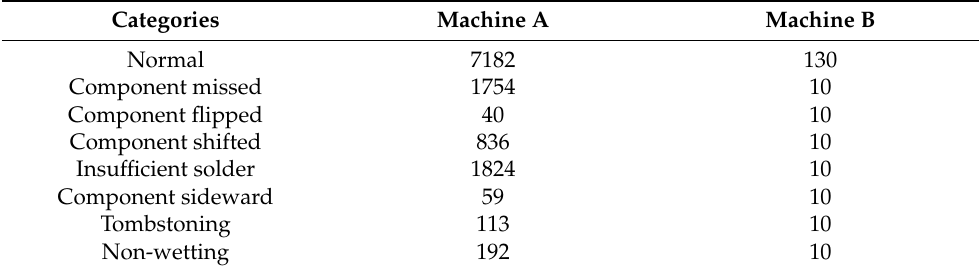
Table 1. Distribution of image categories of machines A and